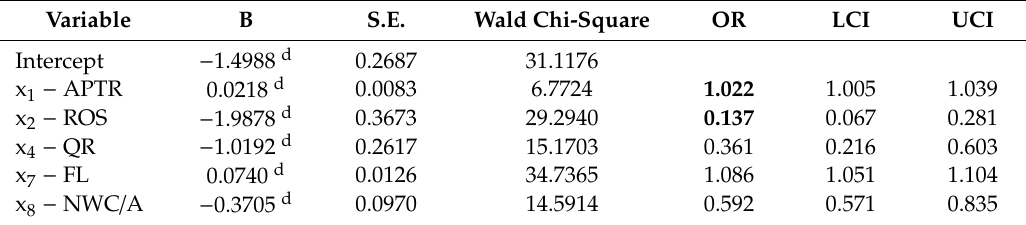
Table 3. Analysis of maximum likelihood